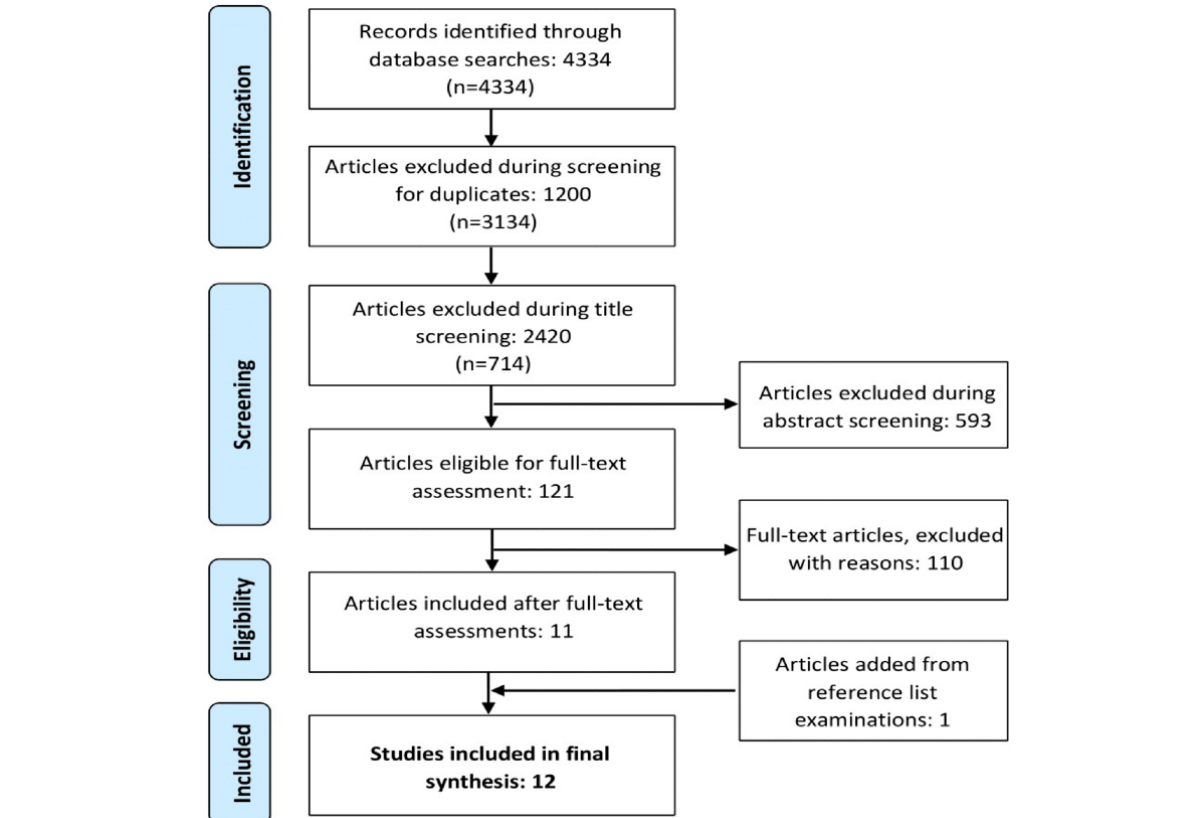
Figure 1. Flow diagram of study selection